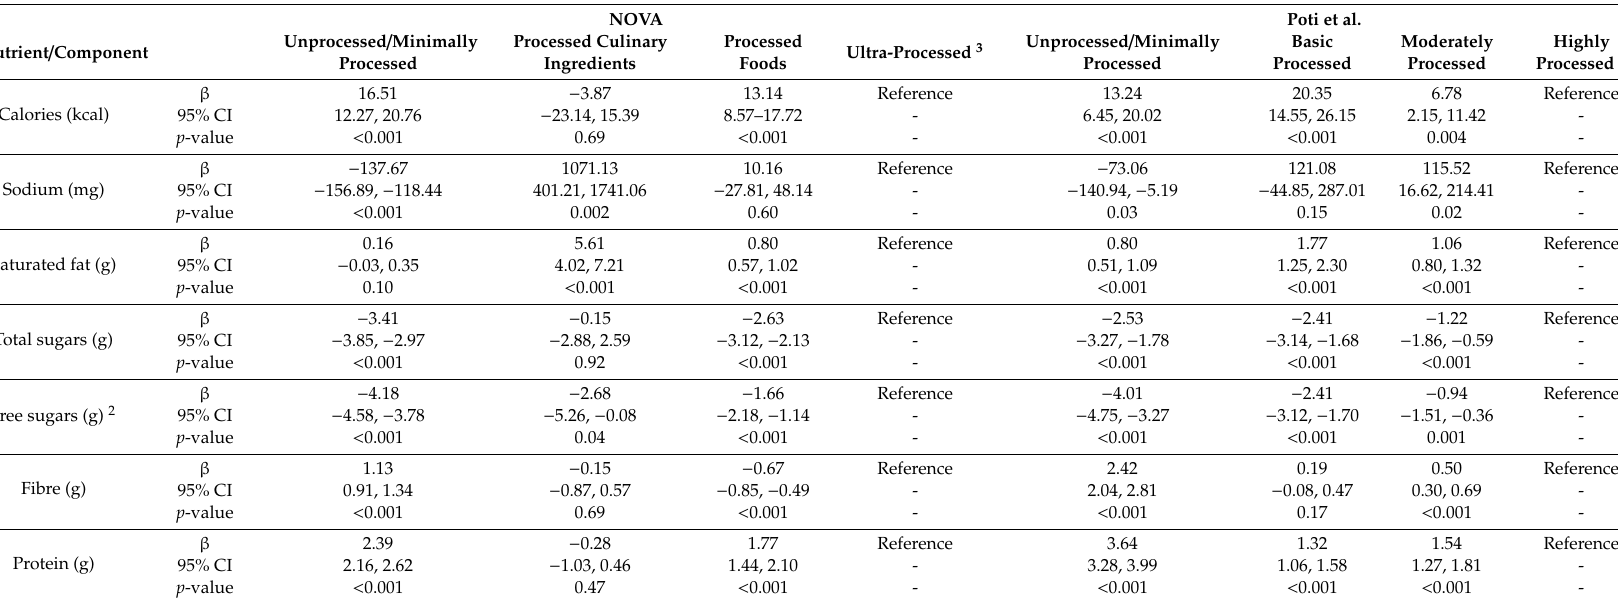
Table 3. Results of the linear regression analyses examining calories, sodium, saturated fat, total sugars, free sugars, fibre and protein per 100 g (or 100 mL) by level of processing according to both the NOVA and Poti et al. classification systems ( n = 17,269) 1,2,3